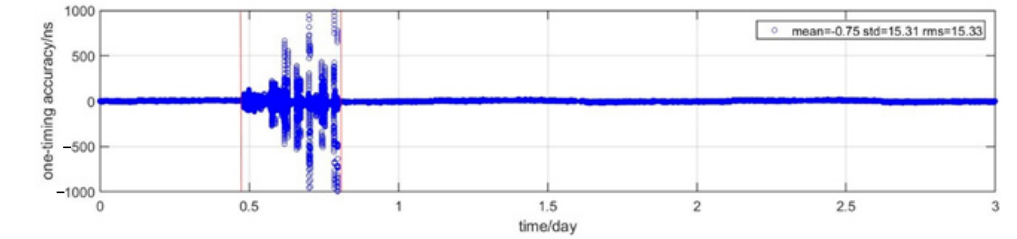
Figure 6 . BDS-3 RDSS one-way timing accuracy (orbit maneuver state) .